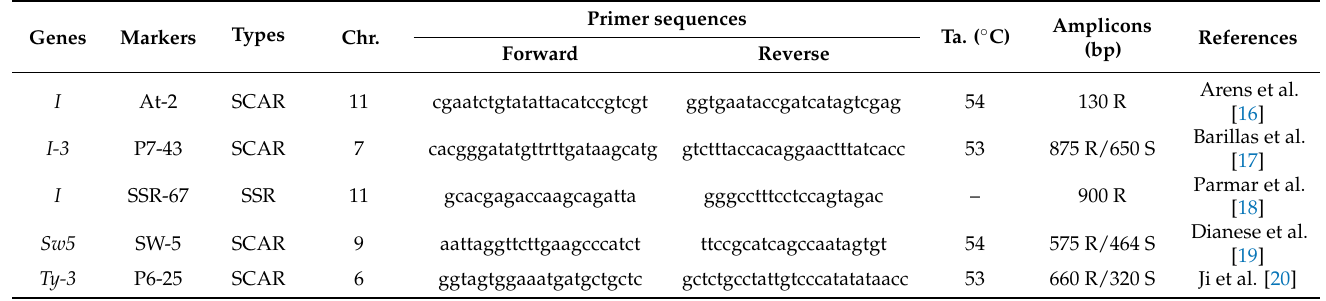
Table 2. Gene locus, primers, molecular marker type, annealing temperature, amplicon base pair and references for the F. oxysporum f. sp. lycopersici molecular markers associated with the resistance genes used in the present